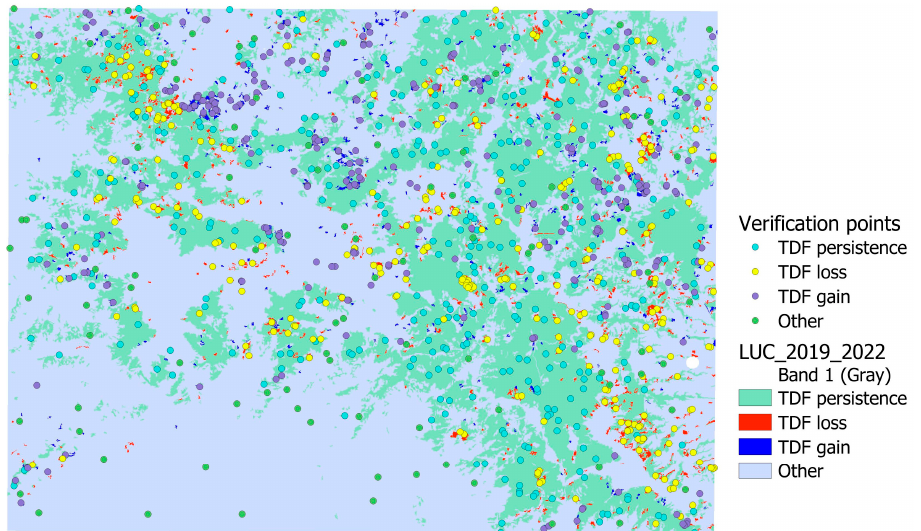
Figure 3. The map of the land use land cover change (LULCC) and the distribution of the verification points.